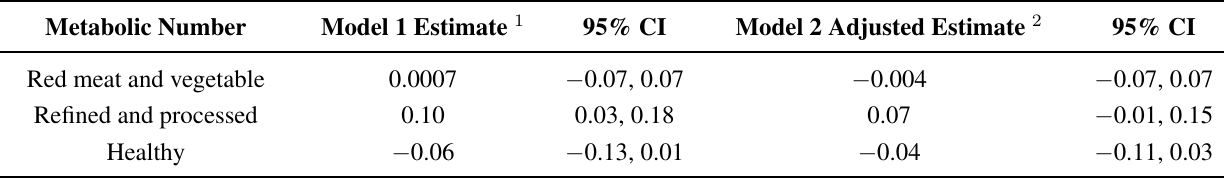
Table 4. Linear regression estimates for number of metabolic abnormalities, according to dietary